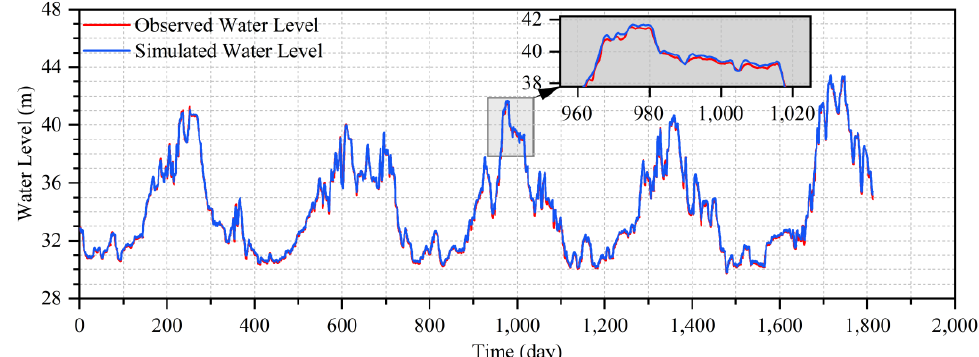
Figure 11. The simulated water level errors of Shashi Station by the GRU during the testing period.